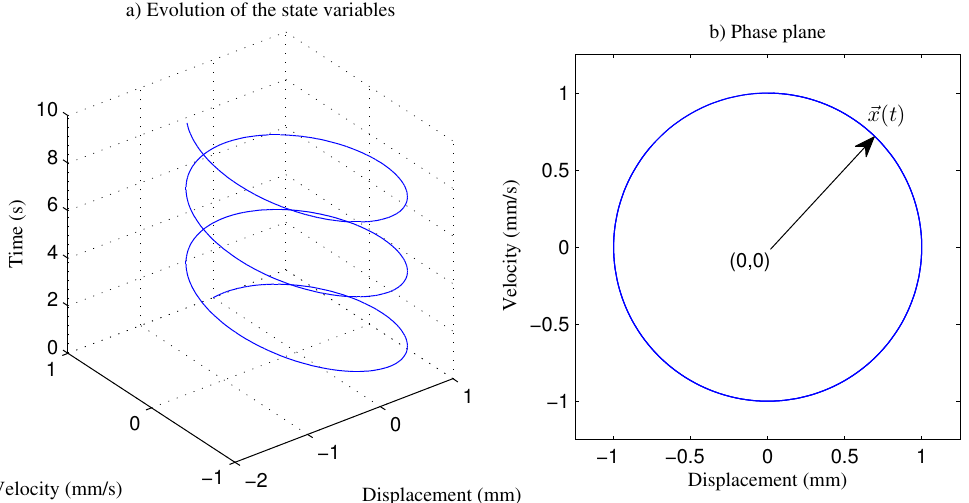
Figure 1. ( a ) Evolution of the state variables; ( b ) phase plane of the linear harmonic for the function: x = sin ( 2 t + φ )